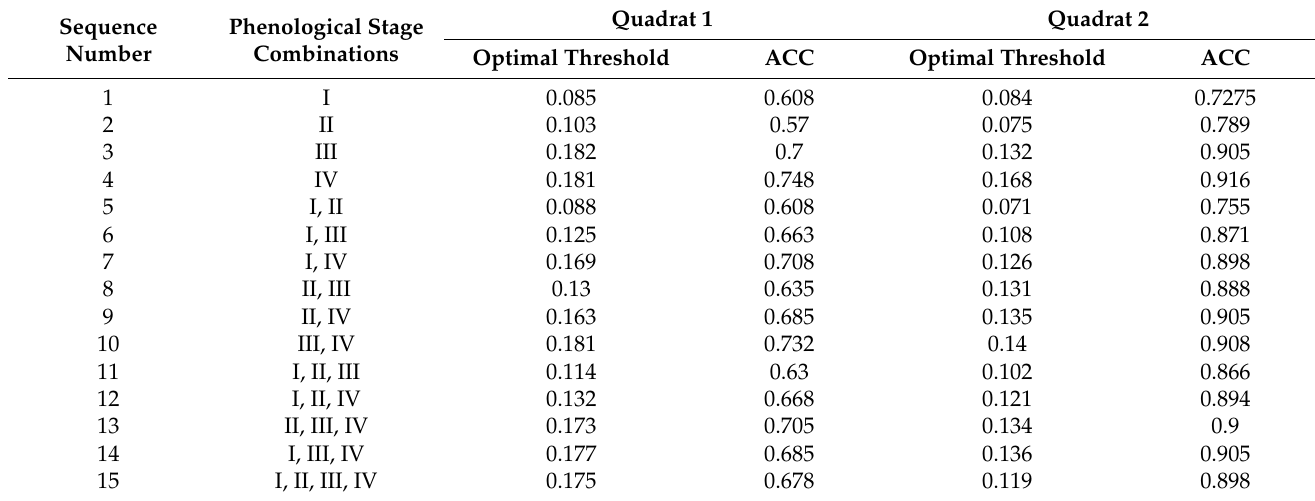
Figure 8. Extraction results of quadrat 2 combination at different phenological stages. ( a ) Single phenophase; ( b ) Combined time series of dual phenology; ( c ) Combined time series of triple phenology; ( d ) Full phenological stage with 1–15 corresponding to the combination numbers of different phenological stages in Table 4. Table 4. DTW threshold and winter wheat extraction accuracy of the combined time series of different phenological stages in quadrat 1 and quadrat